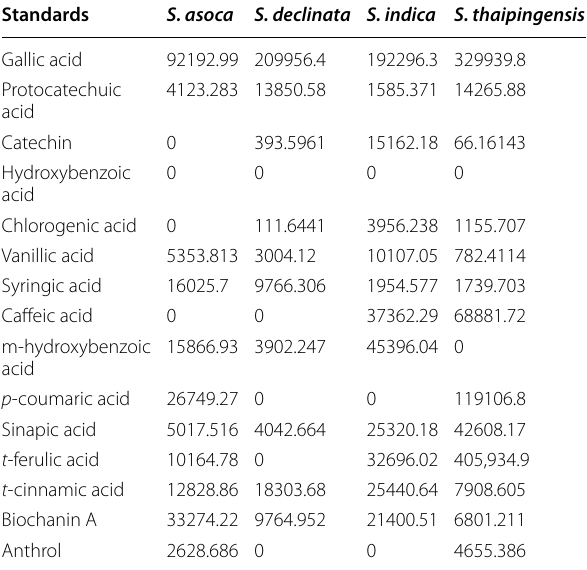
Table 2 Total quantity of phytochemicals (mg/kg of plant